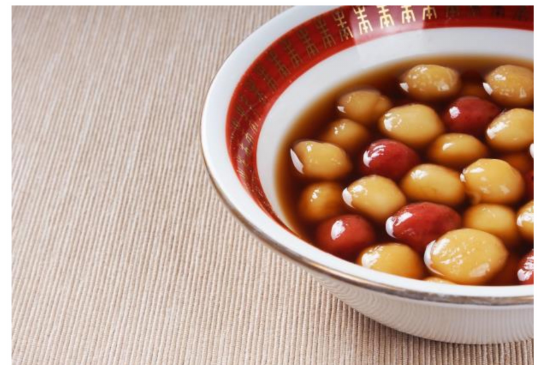
Figure 3. Tangyuan. Source: Unplash. Tangyuan [26].